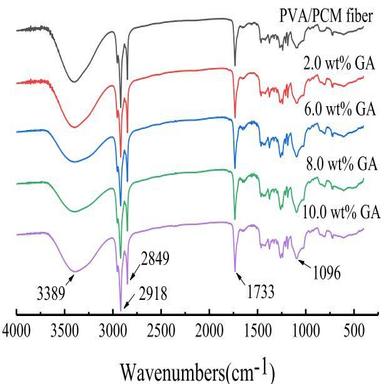
FT-IR curves of PVA/PCM fibers and cross-linked PVA/PCM fibers in different dosages of GA.